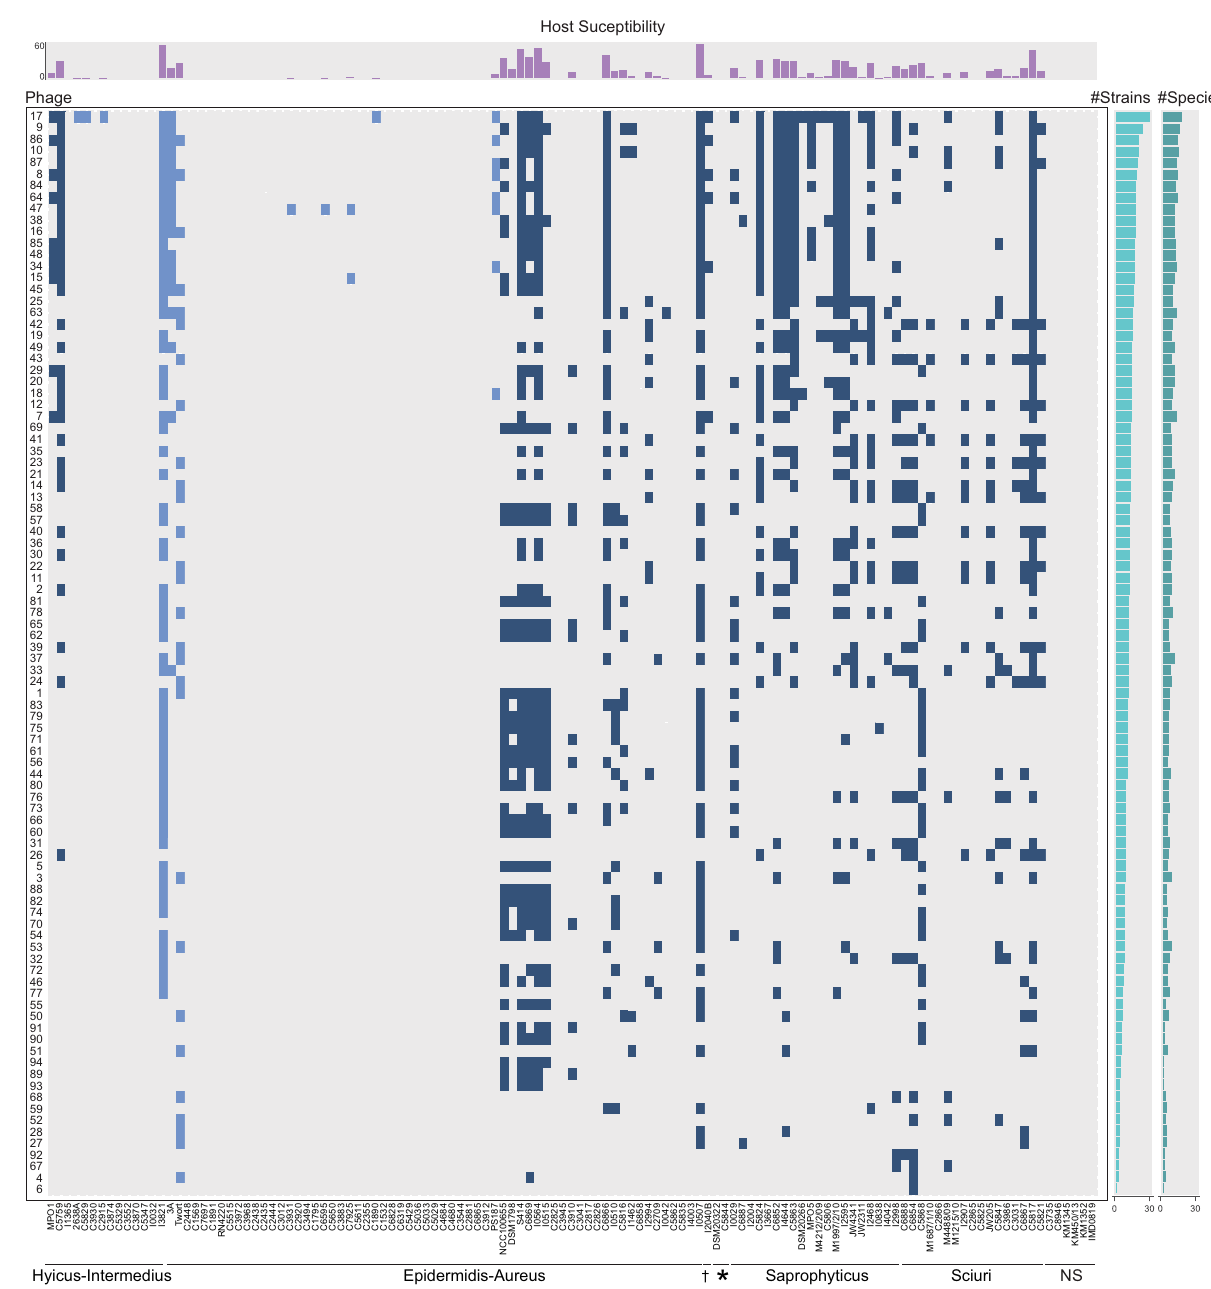
Fig. 1 Staphylococcal phage-bacteria incidence matrix. Bacterial lawns of 123 hosts from 32 species were challenged with 94 different staphylococcal phages from wastewater and phage K. Phages on the y -axis are sorted from broad host range to narrow. Bacterial hosts in columns are sorted after cluster- groups and subdivided species as established in 13 . Dagger: Cluster-group Auricularis. Asterisk: cluster-group Simulans. NS: Non-S taphylococcus hosts. Each blue-colored square of the incidence matrix corresponds to a phage-host infection where single plaques were visible. Squares in dark blue indicate infections on CoNS and squares in light blue on CoPS. The phage permissiveness for each host is indicated in the host susceptibility bar chart on top of the incidence matrix, which represents the number of phages infecting a strain. The two bar charts on the right indicate the total number of strains (number of strains, left) and species (number of species, right) a phage infected. The incidence matrix has a diameter of six and a density of 0.1 ( = 1135/11562). Phages are abbreviated with their fi nal unique numerical identi fi er (PG-2021_*). Source data are provided as a Source Data fi